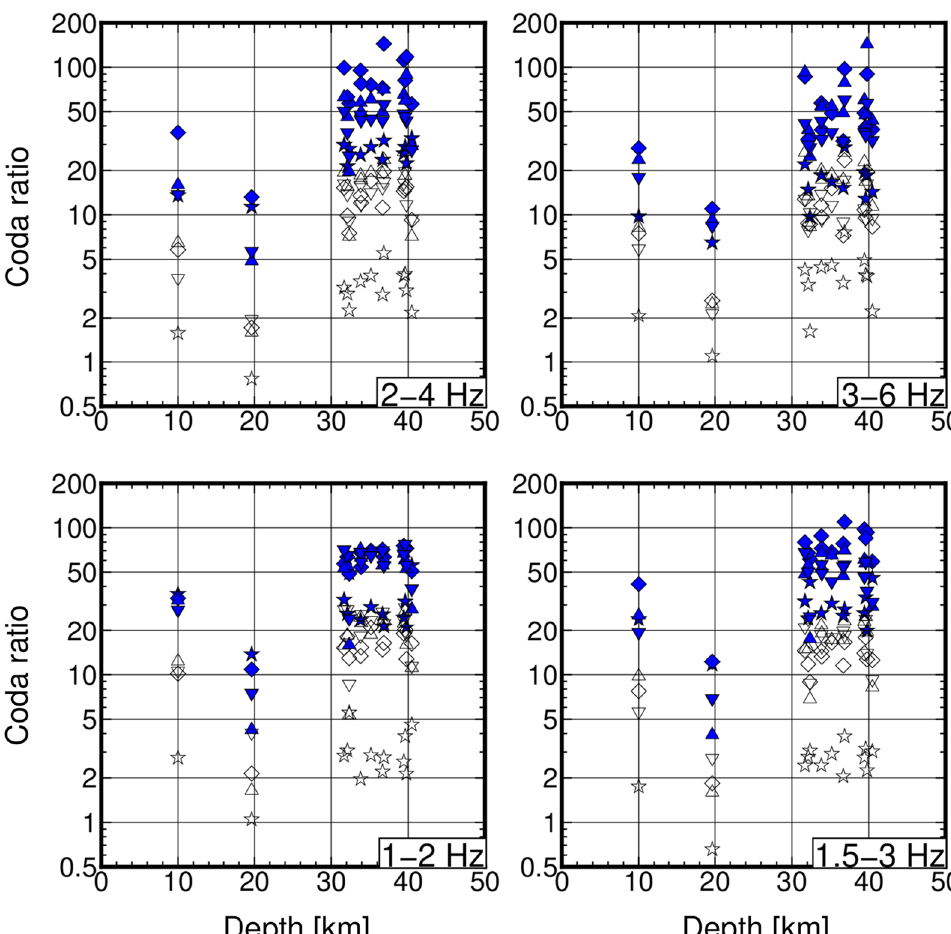
Fig. 3 Coda amplitude ratios at DONET stations as a function of hypocenter depth. The stars, diamonds, triangles, and inverse triangles are coda-amplitude ratios at M.KMA03, M.KMB06, M.KMC09, and M.KMD13, respectively. The filled and open symbols represent coda amplitude ratios for the horizontal and vertical components,